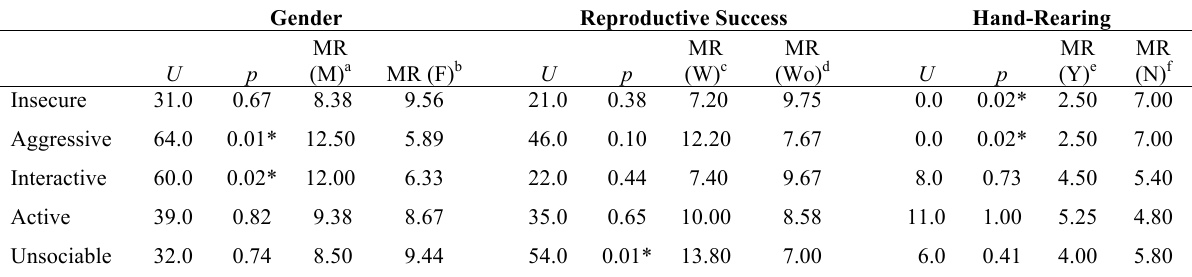
Mann-Whitney U-Test Displaying Personality Components Compared with Gender, Reproductive Success, and Hand-Rearing Gender Reproductive Success Hand-Rearing